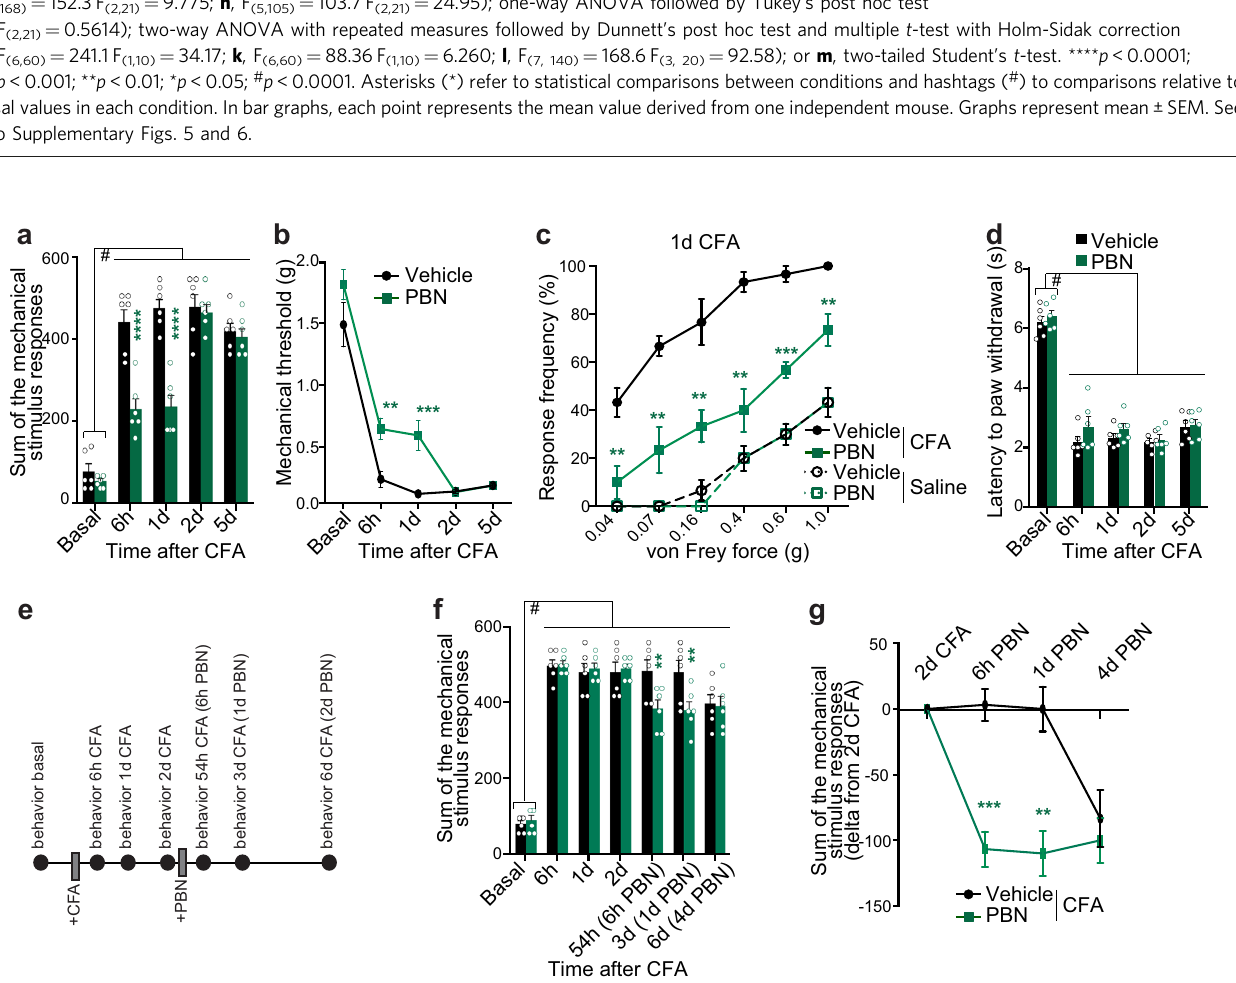
Fig. 5 OAT1 is a functional mediator of in fl ammatory hypersensitivity. a Timeframe of the experiment. b Sum of the stimulus-evoked responses to von Frey fi laments. c 40% response threshold to mechanical force via von Frey fi laments. d Stimulus intensity-response frequency curve for plantar von Frey mechanical stimulation 24h after intraplantar CFA and fi nal intrathecal siRNA injection ( b – d , vehicle, siControl n = 8; siOat1 n = 7). e Timeframe of the experiment and f mechanical sensitivity following intraplantar CFA injection, represented as the average sum of the von Frey stimulus responses. g 40% response threshold to mechanical force via von Frey fi laments. h Stimulus intensity-response frequency curve for plantar von Frey mechanical stimulation 24h post intraplantar CFA ( f – h , n = 8). i Cumulative durations of acute nocifensive behaviors evoked by intraplantar injection of capsaicin for mice intra- spinally injected as indicated ( n = 8). j Mechanical hypersensitivity represented as the average sum of the von Frey stimulus responses. k 40% response threshold to mechanical force via von Frey fi laments. l Stimulus intensity-response frequency curve for plantar von Frey mechanical stimulation 24h after intraplantar CFA injection ( j – l , n = 6). m Cumulative durations of acute nocifensive behaviors evoked by intraplantar injection of capsaicin for mice intra-